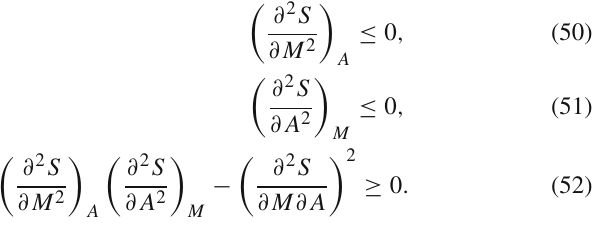
Fig. 6 Upper panel: The figure shows the m ∗ ) curves (full line) for EOS III and several values of and k = k ( R ∗ 0 n . k min = 1 / 5 is the smallest value of k which satisfies the DEC. Lower panel: Ω 20 and Ω 20 c curves for different values of n for the non-barotropic EOS III. As in Fig.4 regarding m ∗ the R ∗ coordinate of each of the coloured dots in the upper and lower 0 panels is the